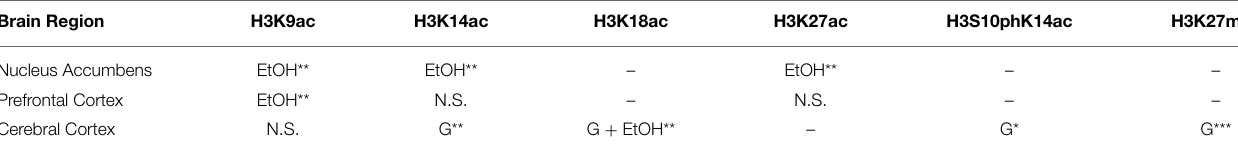
TABLE 2 | Summary of ANOVAs of histone modifications by brain region.